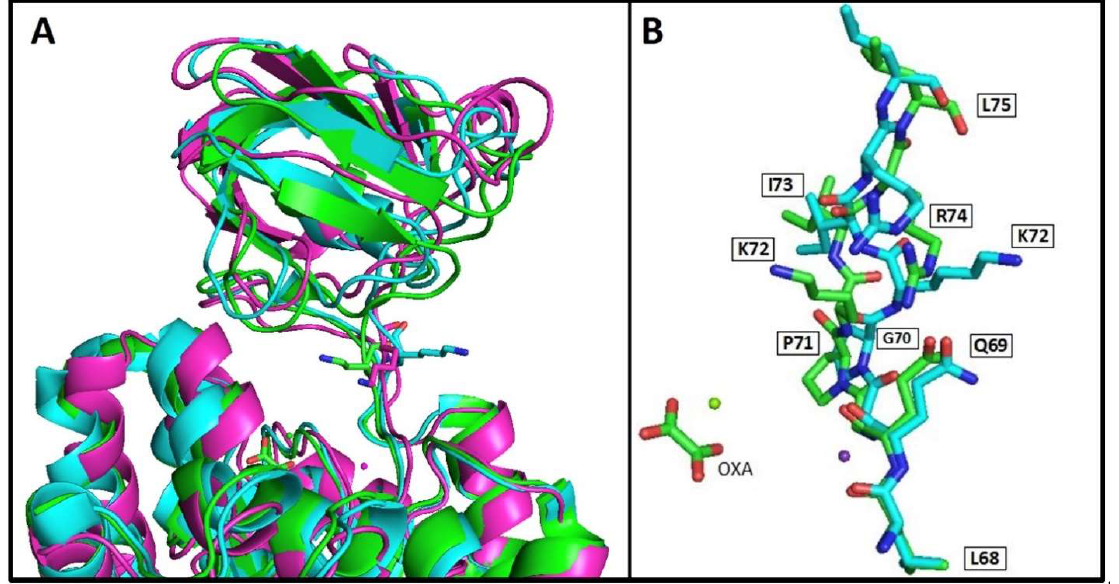
Figure 9. Comparison between residues K117 in E117K mutant (magenta), K72 in the apo (cyan), and holoenzyme (green) in Mtb PK ( A ). Close up of residues L68 to L75 of Mtb PK forming part of the short loop that connects A domain to B domain in the apo (cyan) and holoenzyme (green) on Mtb PK ( B ). In ( A ), the superposition of the E117K mutant coordinates (PDB 7R6Y subunit A; magenta), the holo- Mtb PK (PDB 5WS9 subunit A; green), and the apo- Mtb PK (PDB 5WRP subunit A; cyan) (18) is shown. Residue K72 in Mtb PK corresponds to residue 117 in E117K mutant. The holoenzyme (green) contained oxalate, Mg 2+, Mg-ATP, and K + ; however, the nucleotide was omitted. The oxalate and Mg 2+ present in the RMPK mutant are not shown. In ( B ), the figure shows that apo (cyan) or holoenzyme residues overlap or have the same orientation in the loop except for K72. This figure was prepared using PYMOL v